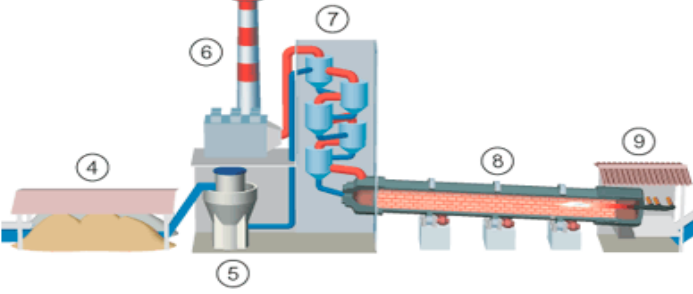
Figure 4. The second phase is the processing of raw sources. Source: own source.